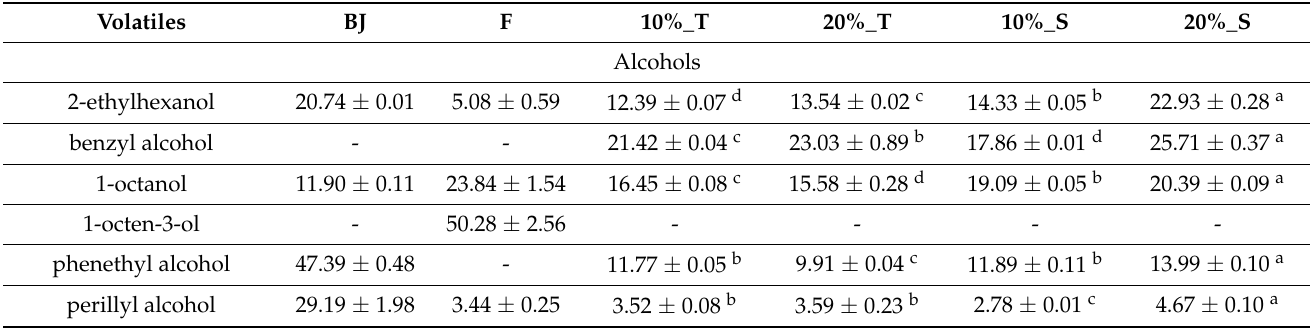
Table 2. The amounts of volatiles of blackberry juice (BJ), citrus fiber (F) and citrus fiber/blackberry gels prepared with different disaccharides after